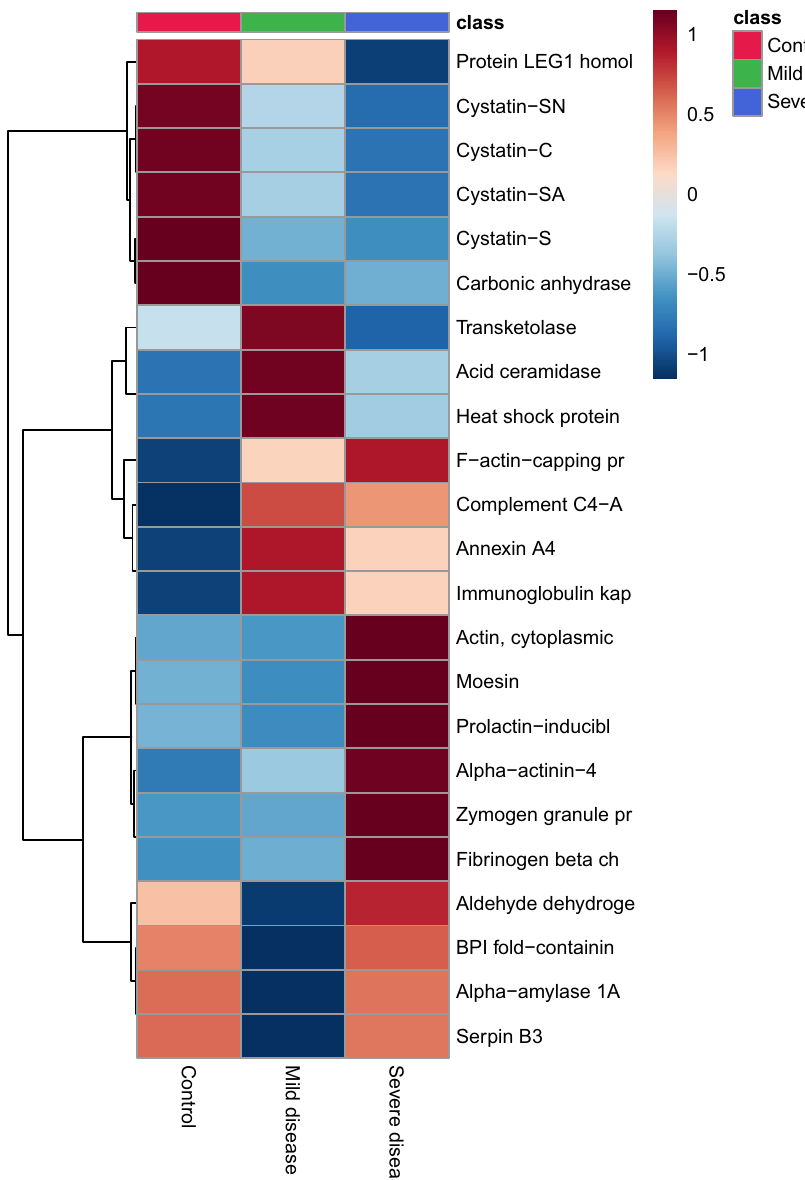
Figure 8. Hierarchical clustering differentiation of the top significant proteins in COVID-19 patients with different severity and controls. Horizontal columns: mean group expression of each biologically relevant protein displaying distinct metabolic patterns between the different severity COVID-19 and control patients. Each bar in the horizontal columns represents the mean expression, where red bands indicate upregulated metabolites and blue bands indicate downregulated proteins within the three groups. Source: Metaboanalyst 5.0 (https:// www. metab oanal yst.